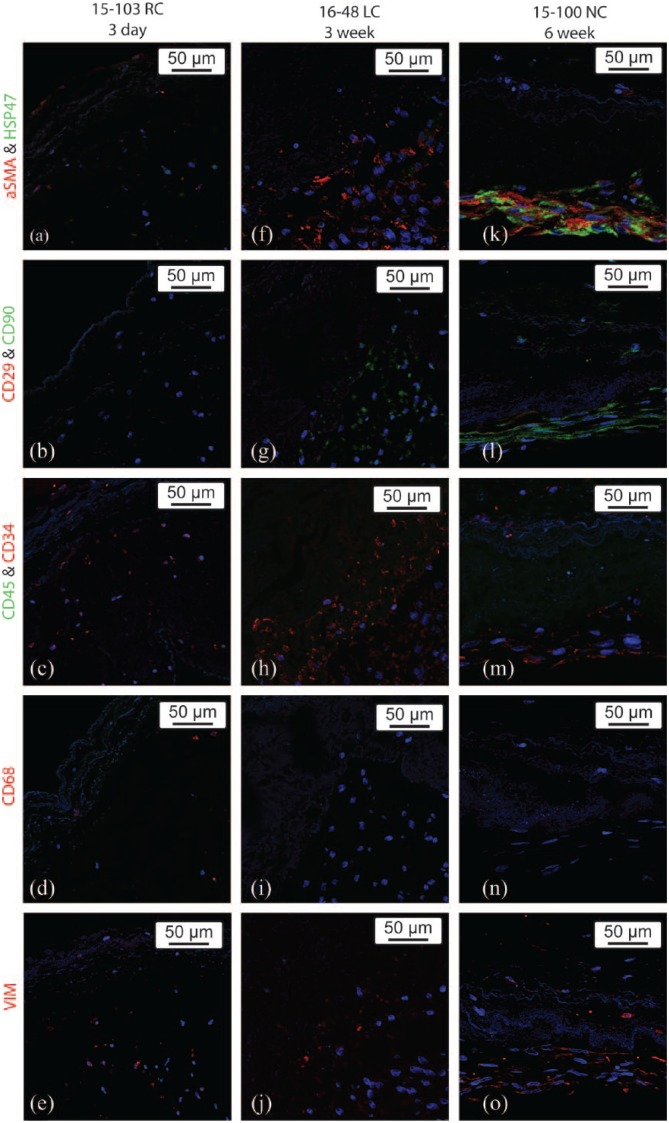
Representative IHC-stained sections of 3-day (a–e), 3-week (f–j), and 6-week (k–o) bioreactor-conditioned heart valve leaflets. Sections were stained for αSMA (red) and HSP47 (green; a, f, and k), CD29 (red) and CD90 (green; b, g, and l), CD45 (green) and CD34 (red; c, h, and m), CD 68 (red; d, i, and n), and VIM (red; e, j, and o).